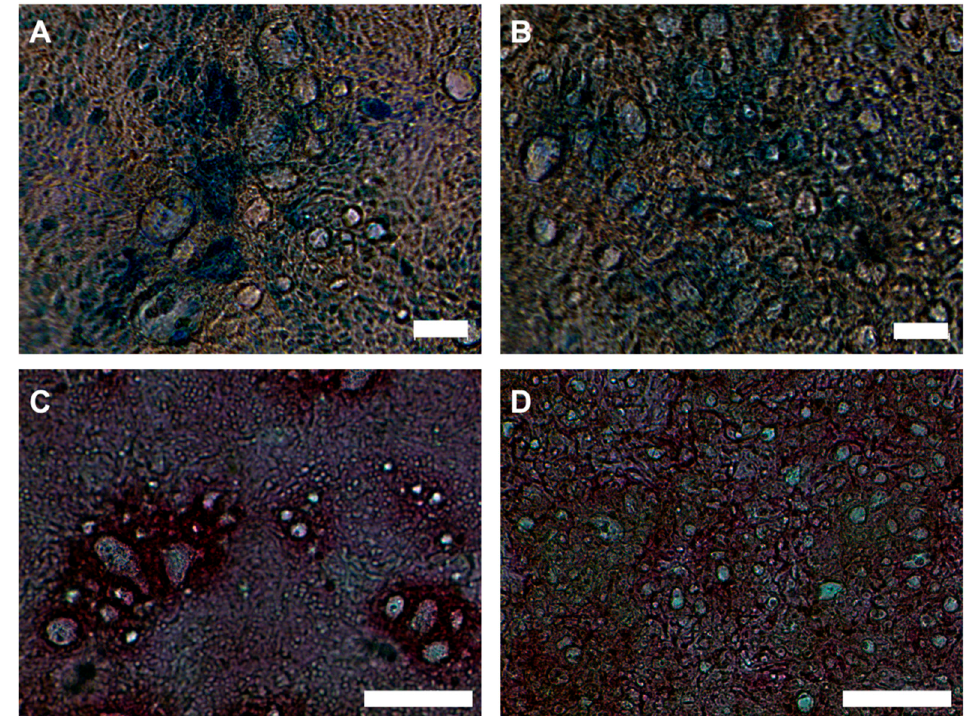
Figure 5. Staining of secreted mucins. CTR ( A , C ) and ZD ( B , D ) cultivation of HT-29-MTX for 14 days. Histological staining of mucins was performed with alcian blue ( A , B ) and PAS ( C , D ). Shown are representative images from three independent experiments. Scale bar 50 µm.